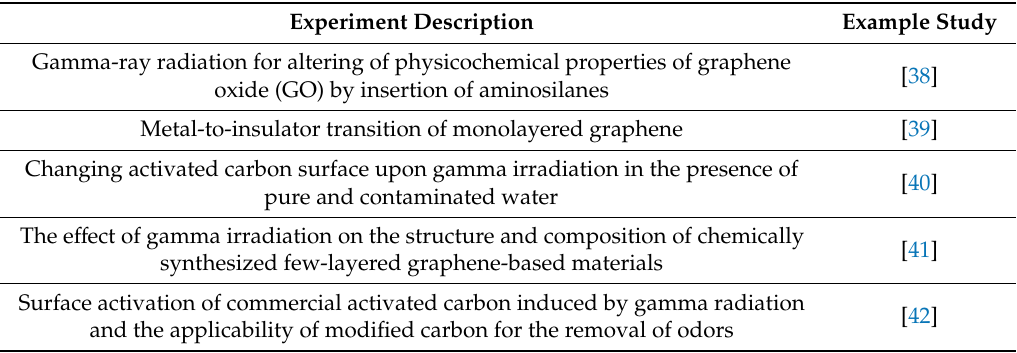
Table 2. Example application of gamma radiation for physical and chemical modification of carbon-type